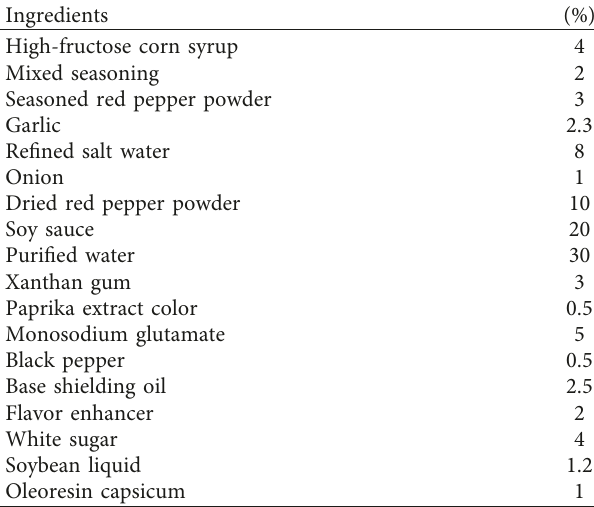
Table 1: Ingredients of sauce used in this study.